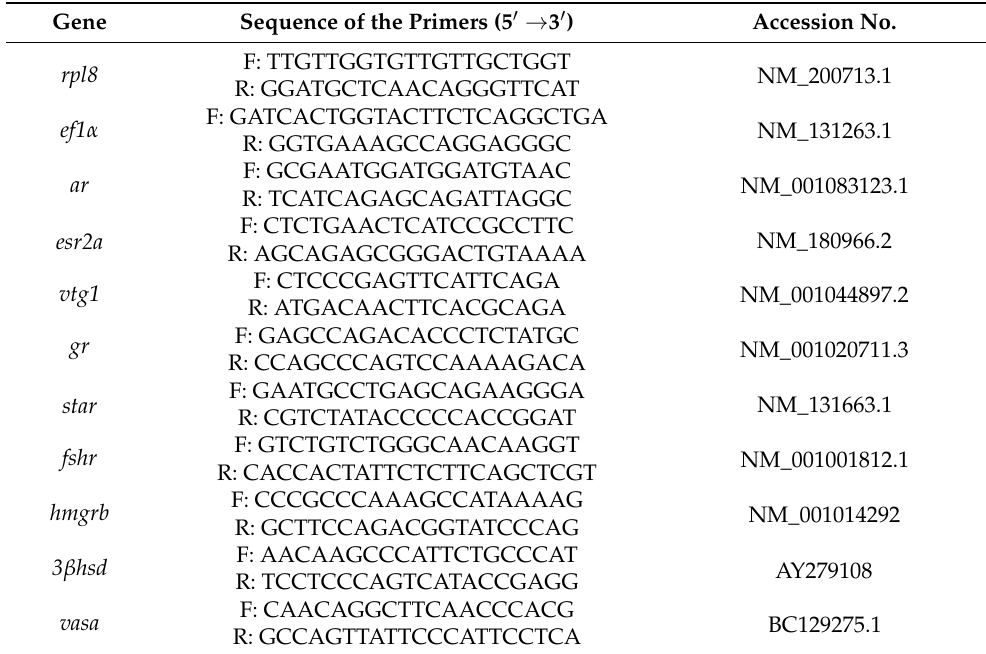
Table 1. Gene primer